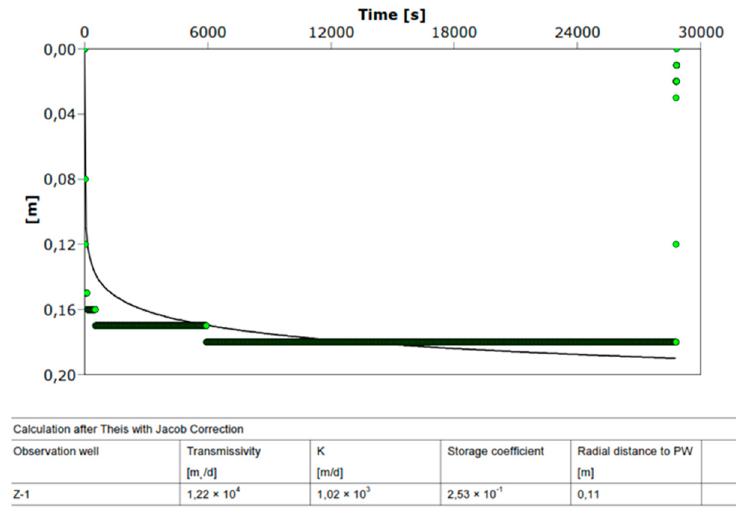
Figure 16. Aquifer parameters obtained at well Z-1, constant test (4 April 2017).